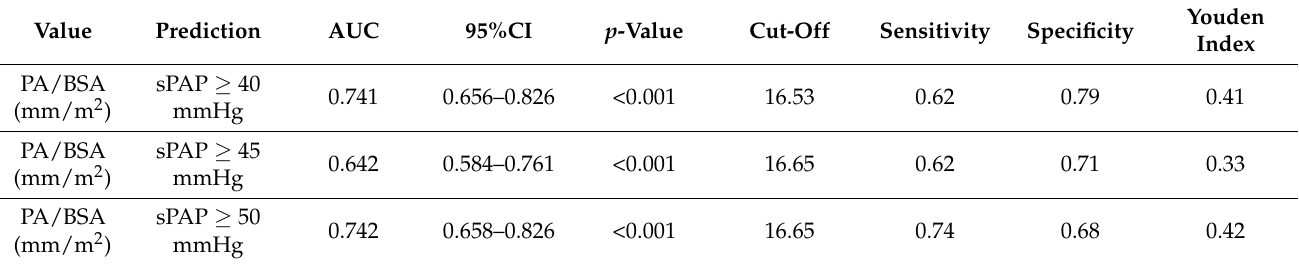
Figure 2. AUROC curves of PA/BSA values for the prediction of sPAP ≥ 40, 45, and 50 mmHg with concerning cut-off values, Youden Indexes, sensitivity, and specificity . sPAP: systolic pulmonary artery pressure. Table 3. Tabular overview of AUROC analyses of PA/AA-Ratio for prediction of sPAP ≥ 40, 45, and 50 mmHg with concerning cut-off values, Youden Index, sensitivity, and specificity .